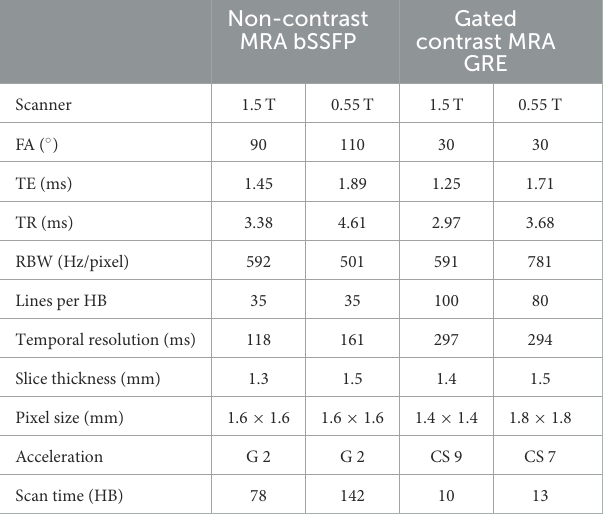
TABLE 6 Acquisition parameters for magnetic resonance angiogram (MRA) images at 0.55T in comparison to 1.5T. Non-contrast MRA